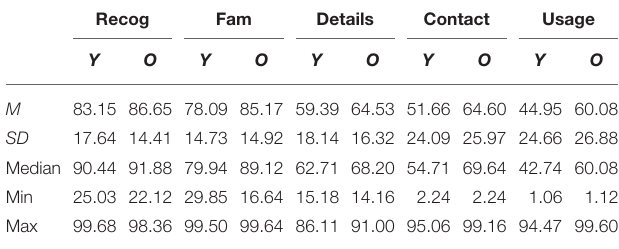
TABLE 1 | Summary statistics for all